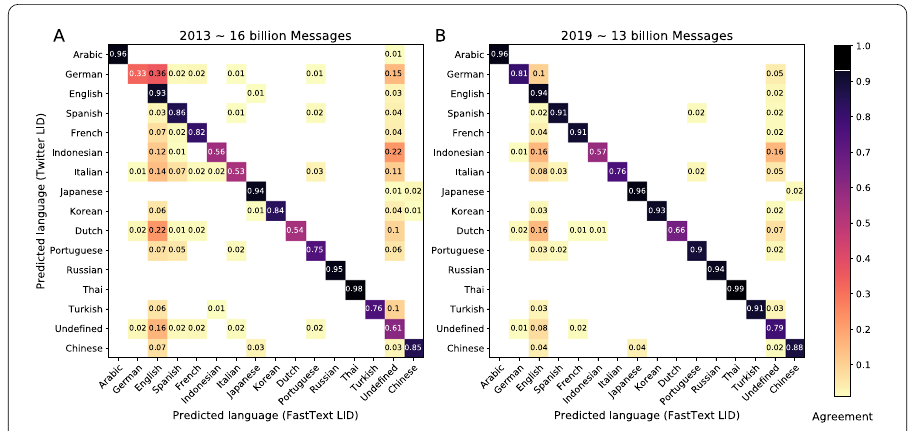
Figure 7 Language identification confusion matrices. We show a subset of the full confusion matrix for top-15 languages on Twitter. ( A ) Confusion matrix for tweets authored in 2013. The matrix indicates substantial disagreement between the two classifiers during 2013, the first year of Twitter’s efforts to provide language labels. ( B ) For the year 2019, both classifiers agree on the majority of tweets as indicated by the dark diagonal line in the matrix. Minor disagreement between the two classifiers is evident for particular languages, including German, Italian, and Undefined, and there is major disagreement for Indonesian and Dutch. Cells with values below 0.01 are colored in white to indicate very minor disagreement between the two classifiers